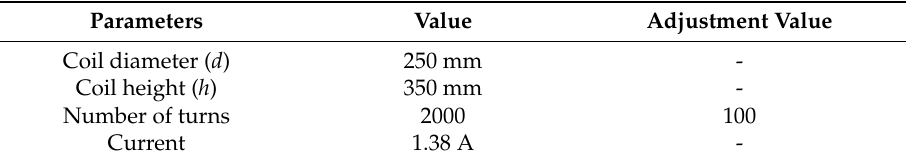
Table 6. Parameters of small-scale model.